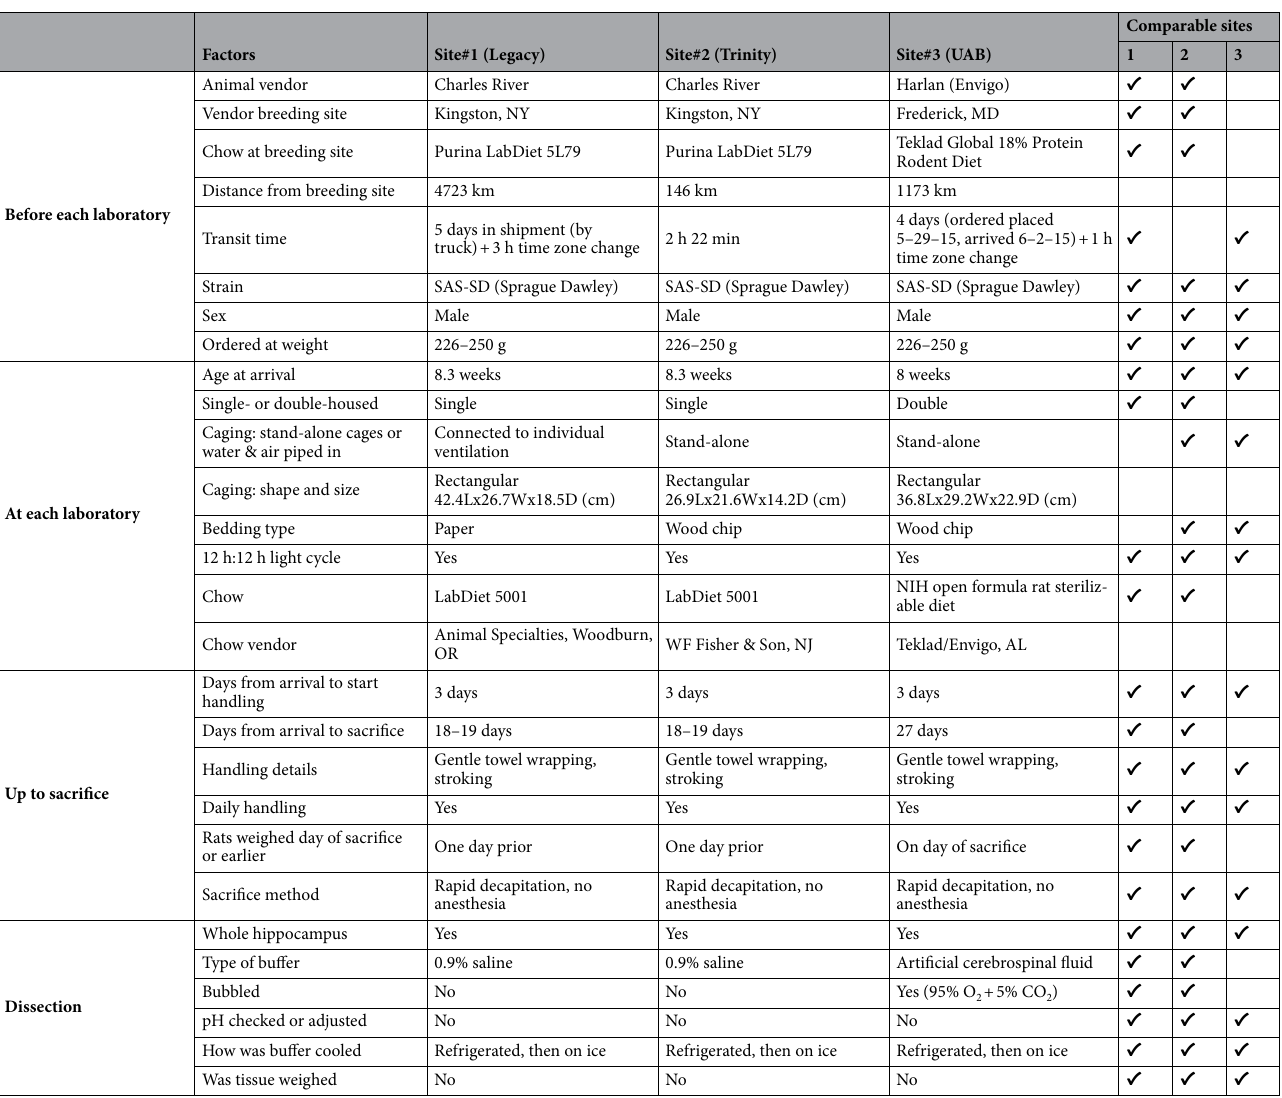
Table 1. Experimental and environmental factors. Site #1: Legacy Research, Site #2: Trinity College, and Site #3: the University of Alabama at Birmingham; SD: Sprague Dawley rat; ✔ : comparable across sites. Animal handling was approved by the Institutional Animal Care and Use Committee (IACUC) at each of the three